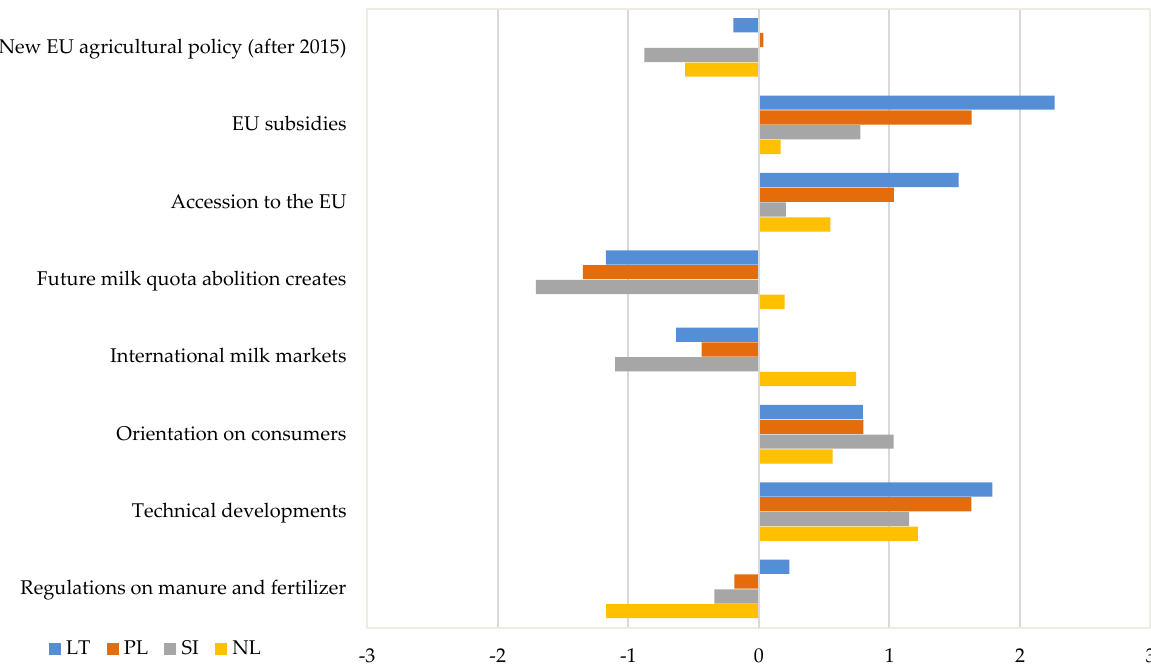
Figure 5. Perceptions averaged over years 2013 and 2016 based on original questions composing the Opportunities and Threats component (scale transformed to −3 big threat to +3 big opportunity for illustrative purpose).